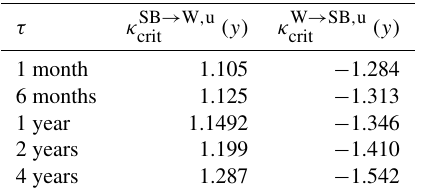
for SB → W (second col- crit